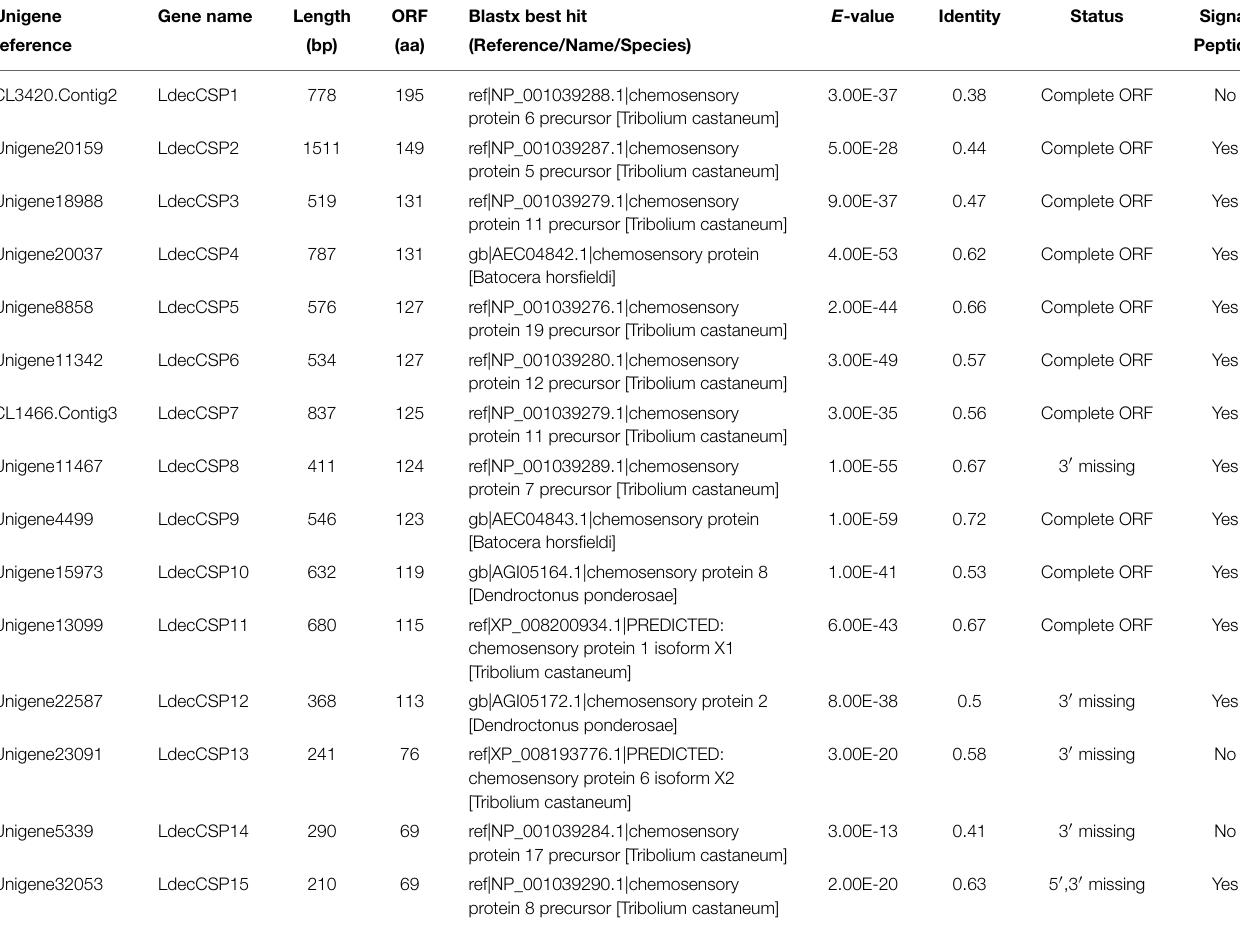
TABLE 3 | Unigenes of candidate chemosensory proteins.